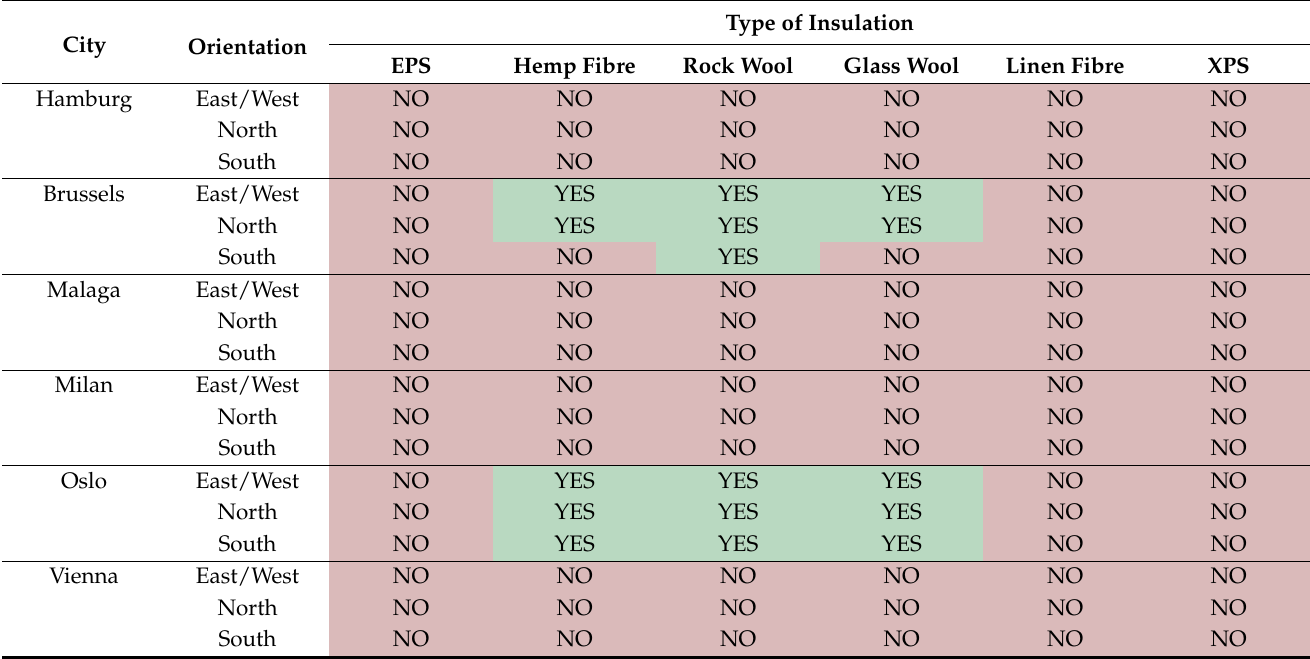
Linen Fibre XPS